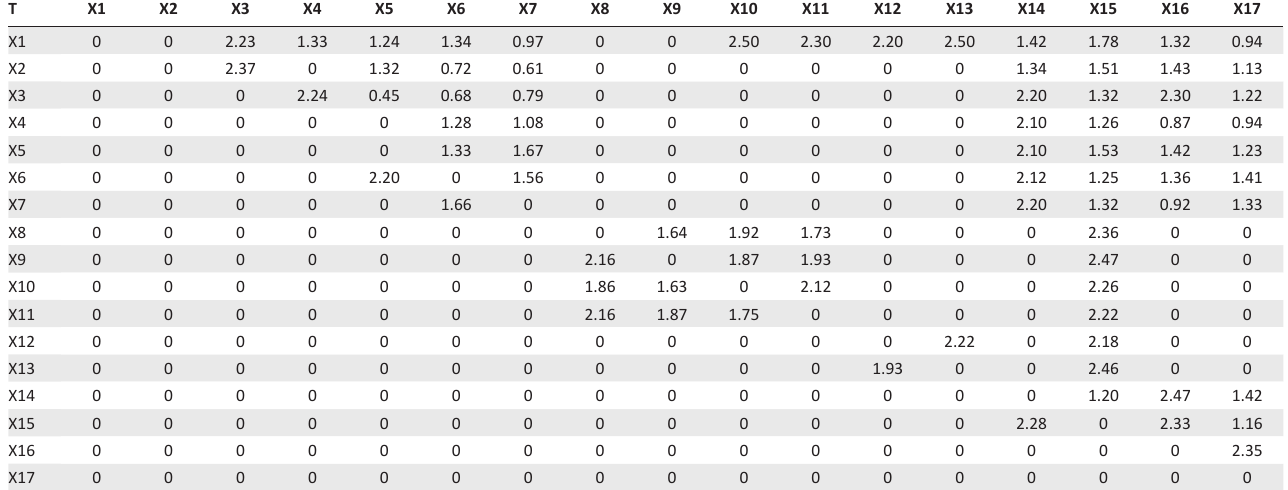
TABLE 1: Direct-relation matrix,